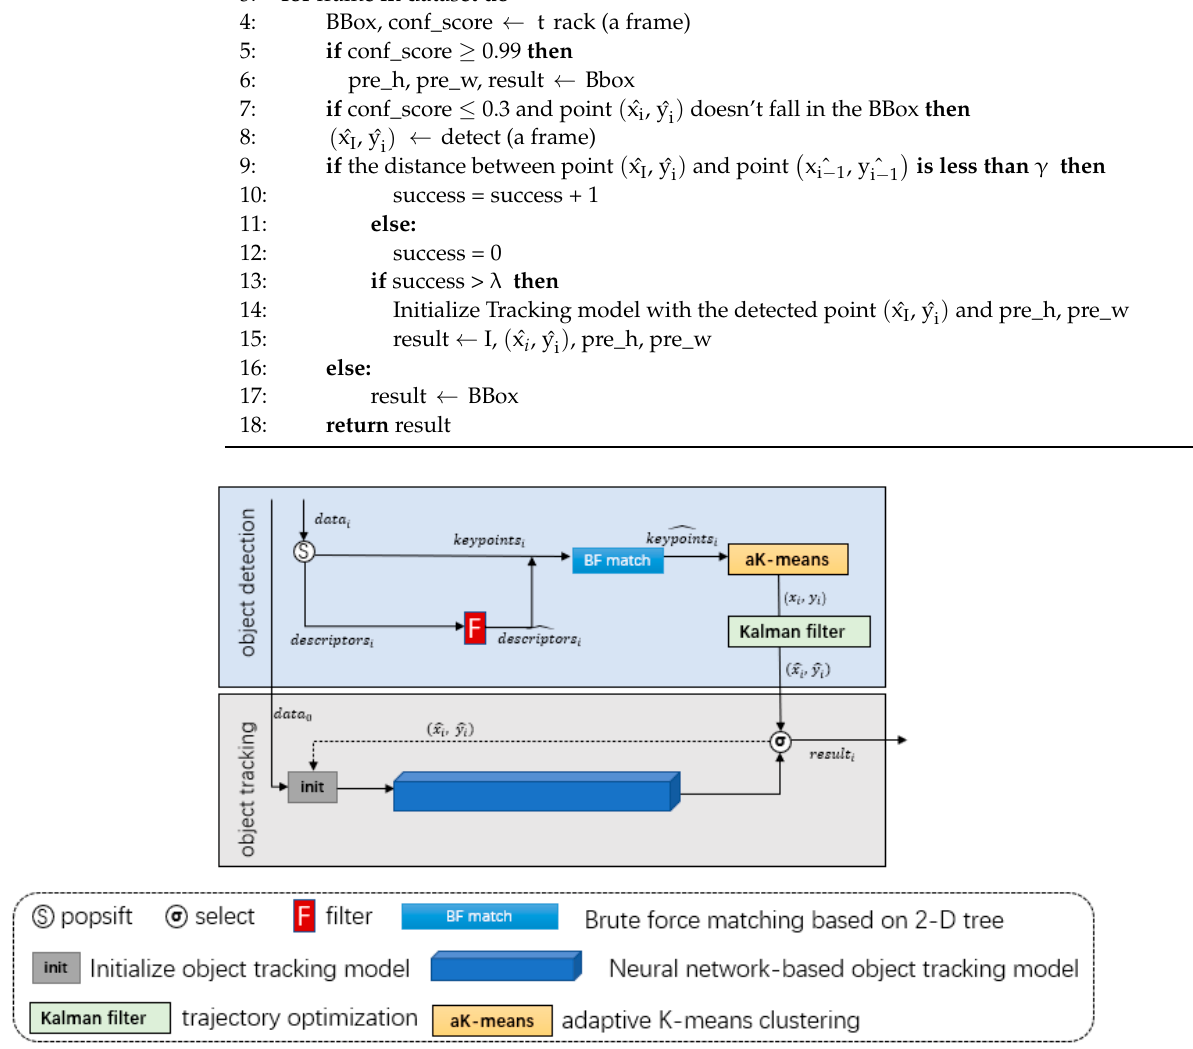
Figure 6. Flow chart of model based on feature registration correction. Algorithm 3: Video Target Tracking and Correction.